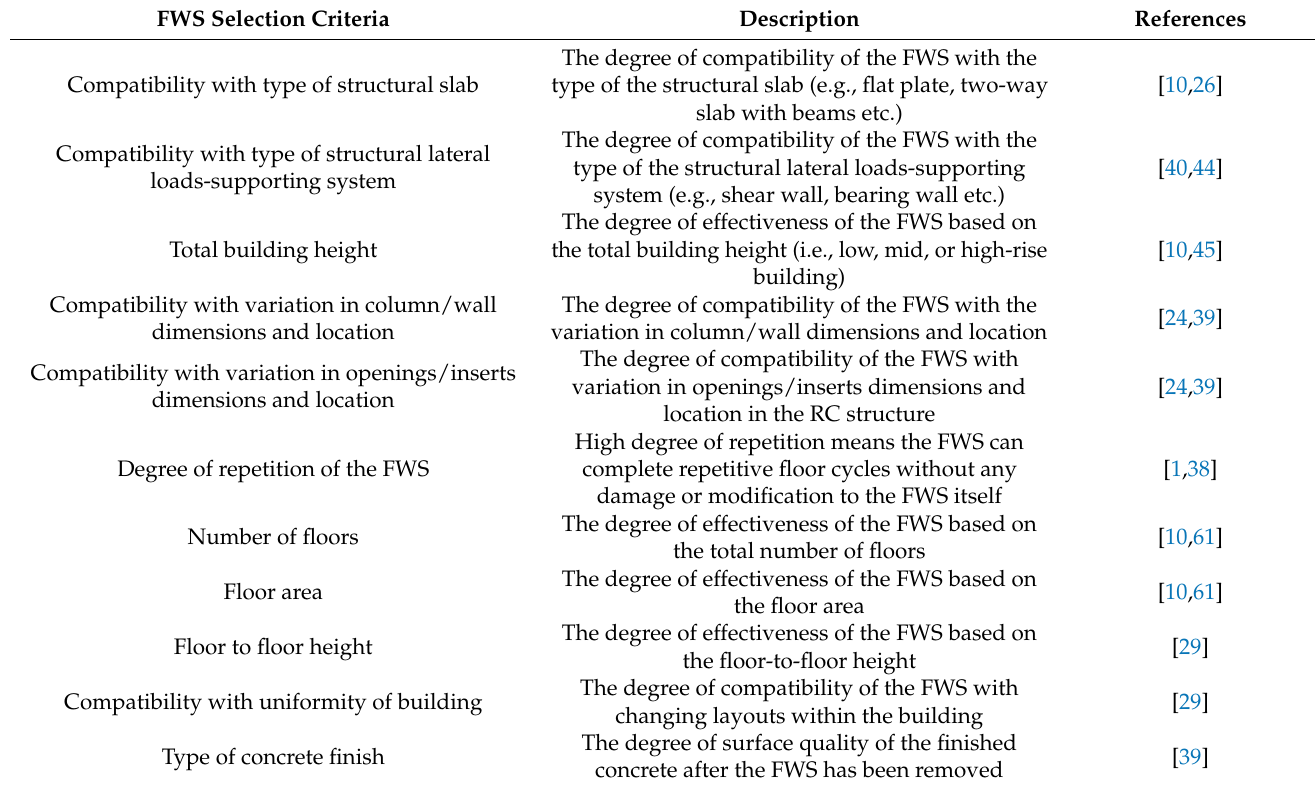
Table 1. FWS selection criteria for building construction projects, adapted from Refs.